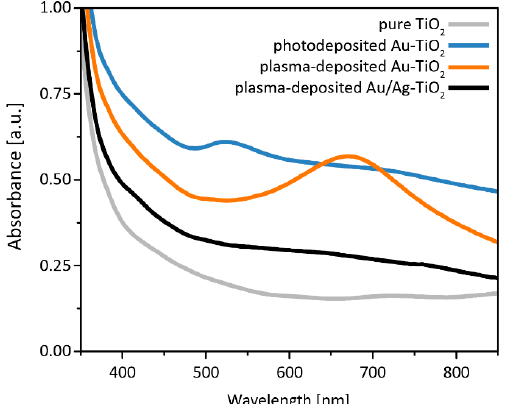
Figure 6. UV-vis spectra showing the absorbance of all samples.